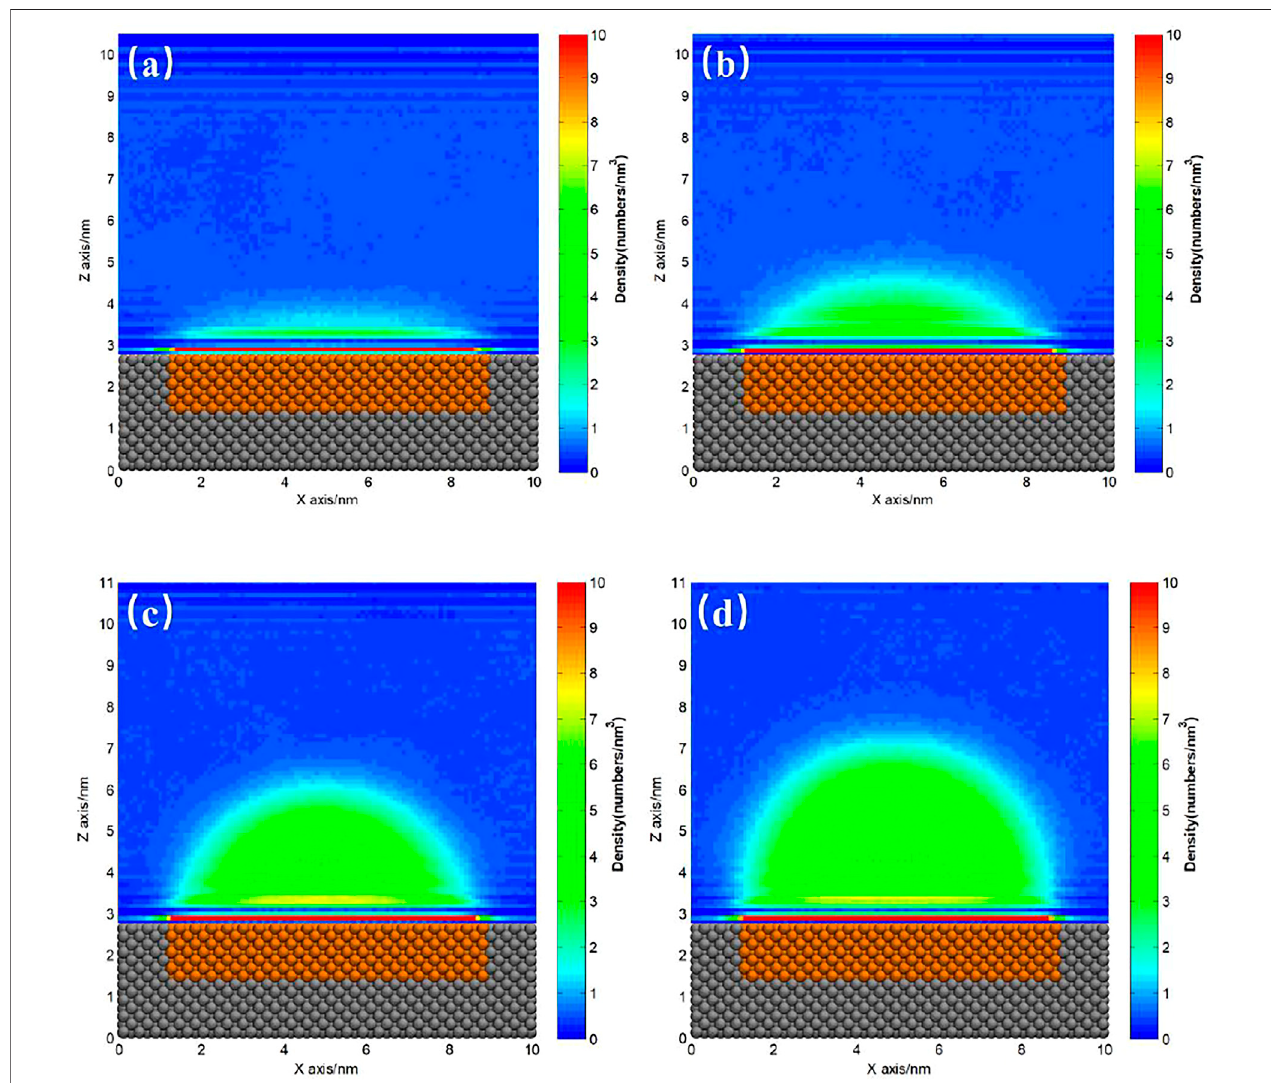
FIGURE 4 | Gas density distribution map averaged from 20 to 120 ns for S M patterned hydrophilic substrate. (A) 150, (B) 200, (C) 300, (D) 400 gas molecules.